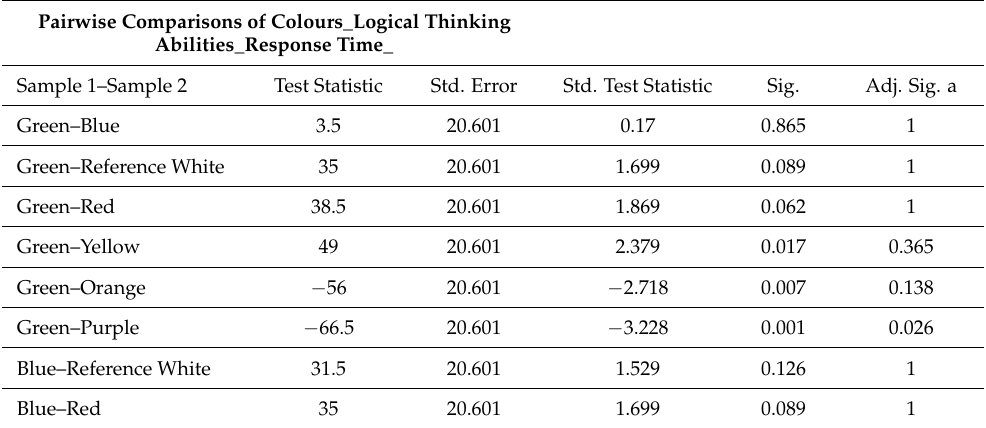
Table A13. Effects on response time (logical thinking